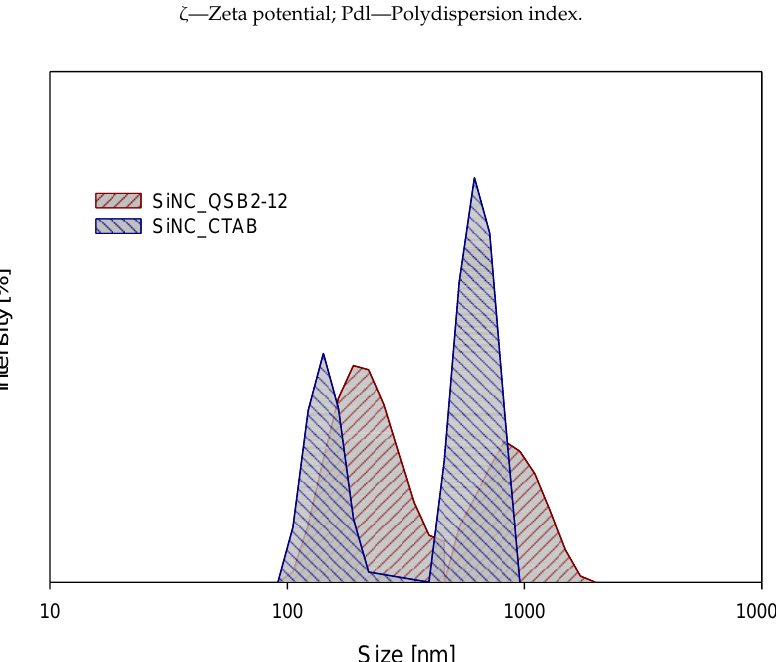
Figure 5. Size distribution of silica nanocontainers (SiNC) synthesized with CTAB and QSB2-12.